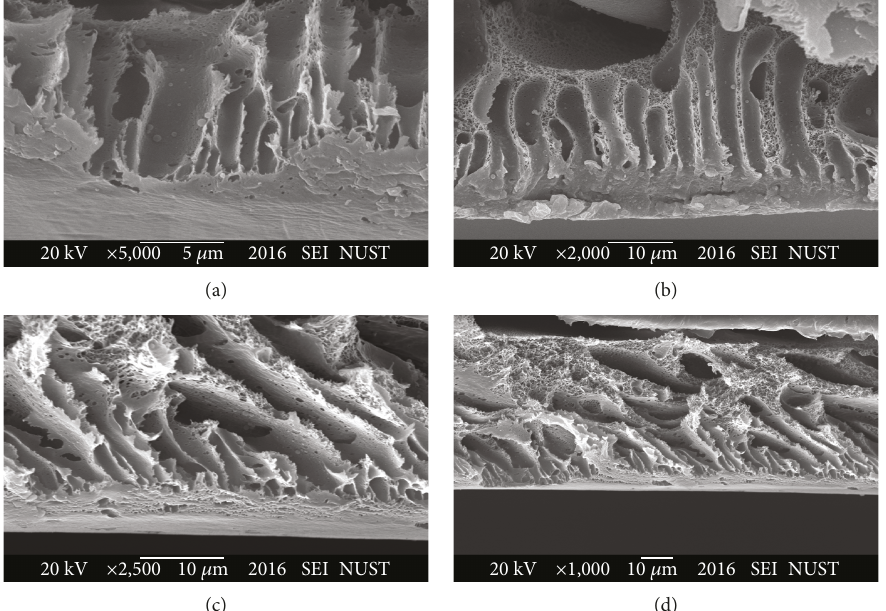
Figure 6: SEM micrographs of the prepared GO-PES membranes: (a) pristine PES membranes, (b) 0.25wt. % (M1), (c) 0.5wt. % (M2), and (d) 1.0 wt. % (M4).